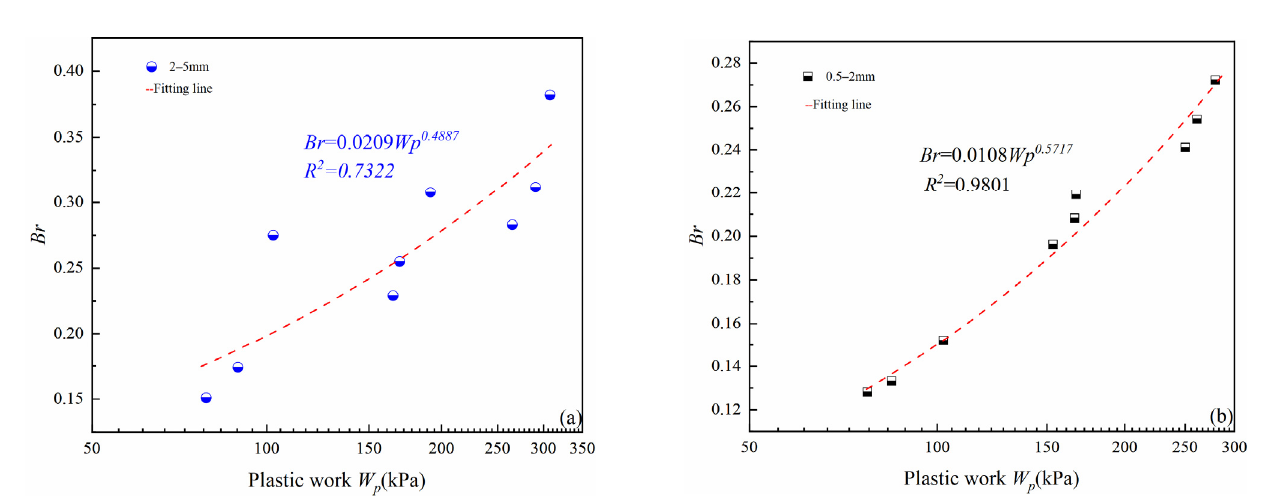
Figure 20. Variations in relative breakage rate with plastic work: ( a ) 2–5 mm particle groups; ( b ) 0.5– 2 mm particle groups. ( b ) 0.5–2 mm particle